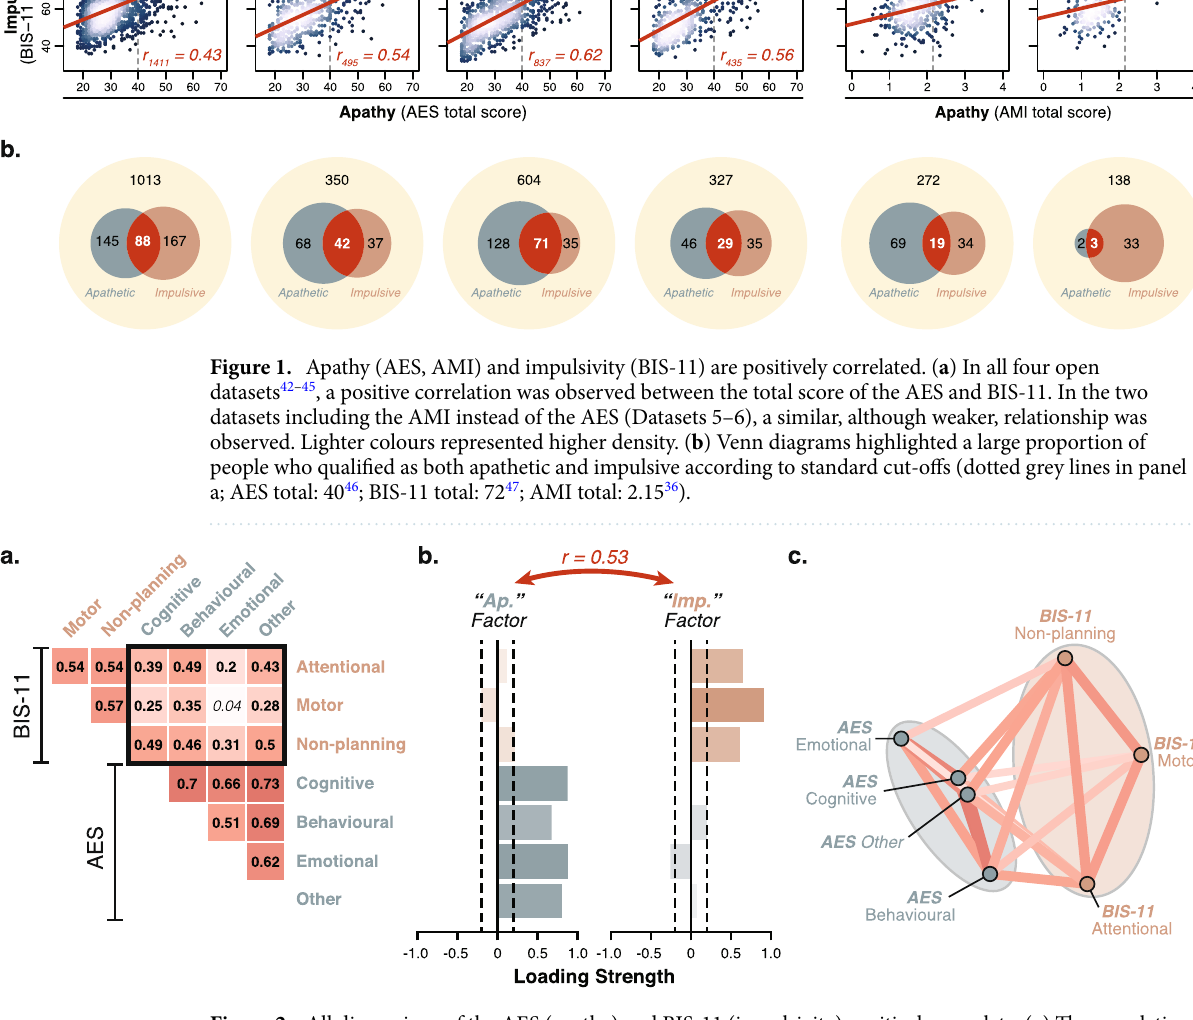
Figure 2. All dimensions of the AES (apathy) and BIS-11 (impulsivity) positively correlate. ( a ) The correlation matrix of the sub-scale scores of the AES and BIS-11 questionnaires showed positive correlations only ( n = 3185 ; Datasets 1–4). Significant pairwise correlations are shown in bold (Bonferroni-corrected). The black square highlights cross-questionnaire associations. ( b ) Factor decomposition (EFA) of this matrix uncovered dissociable, nevertheless positively correlated ( r = 0.53 ), “Apathy” and “Impulsivity” factors. ( c ) In this network plot, sub-scale scores that are more highly correlated (positively or negatively) appear closer together and are joined by stronger paths (non-significant paths removed). Paths are also coloured by their sign (red for positive and blue negative). Ellipses are drawn around the sub-scores included in a factor. Note, here all paths are positive, even those connecting the two factors together. See also Fig. S1 for the same plots split by